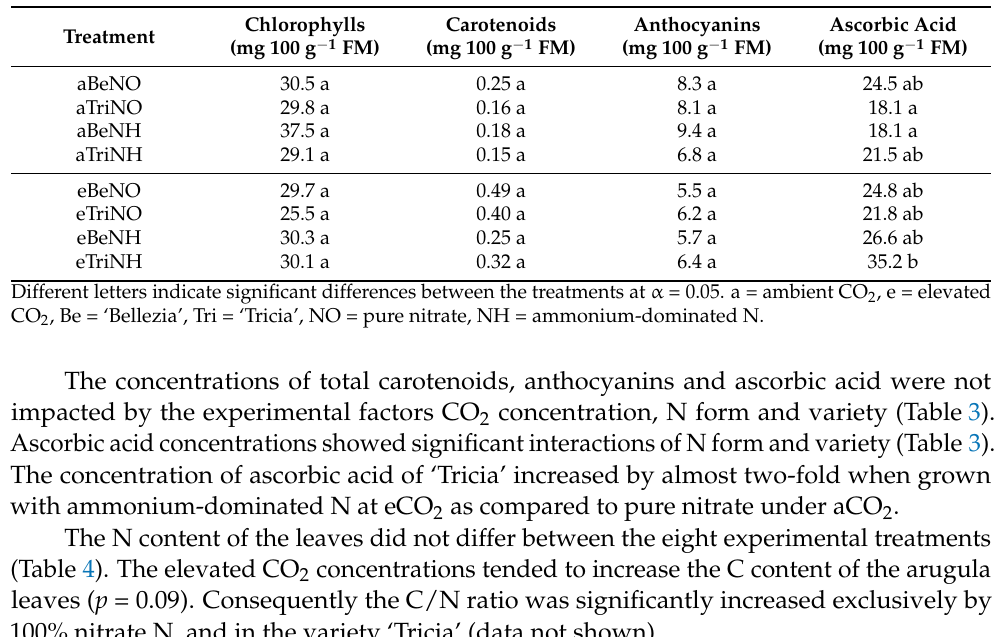
100% nitrate N, and in the variety ‘Tricia’ (data not shown). Table 4. Concentration of macro- and micronutrients in above-ground dry mass of arugula. n = 3. Element